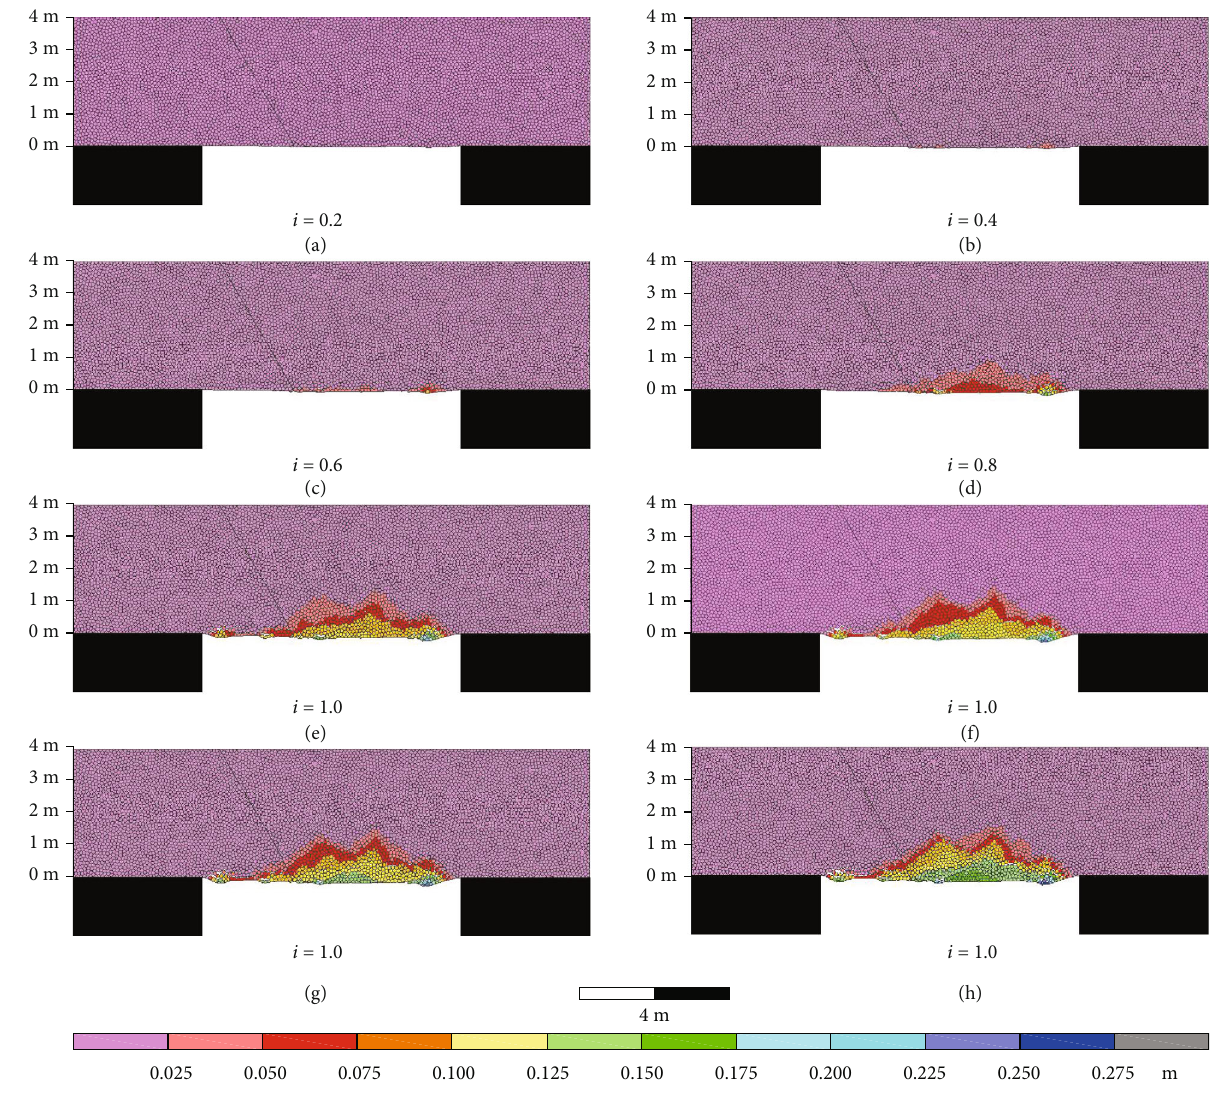
Figure 9: Cloud diagram of total displacement under di ff erent stress release coe ffi cients.